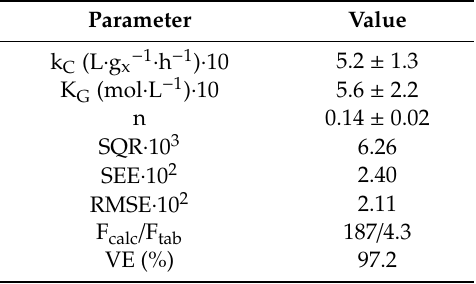
Table 6. Kinetic and statistical parameters calculated for medium agitation experiments with a mix control of the mass transfer and the reaction rate. Runs 20 and 21 conducted in STBR. Model Equation